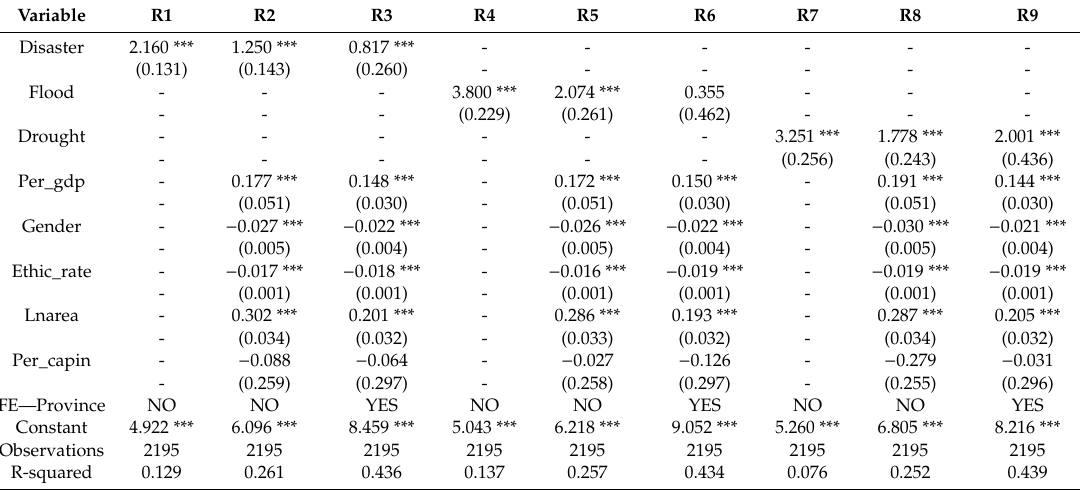
Table 2. Original linear model of frequency of disasters and human capital, ordinary-least-squares (OLS)